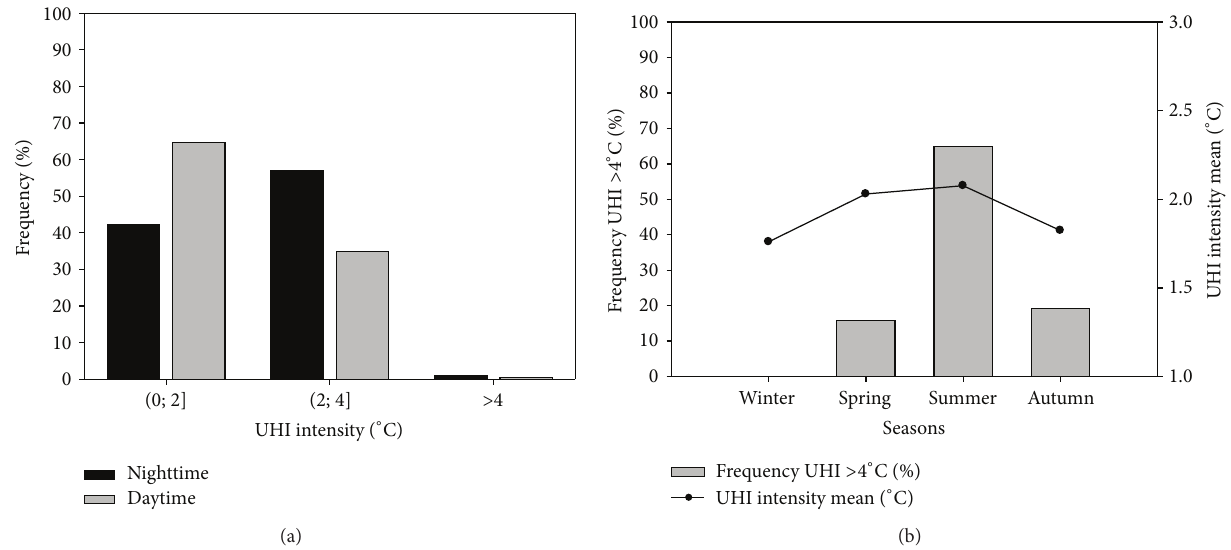
Figure 8: Frequency of the UHII during night- and daytime periods (a) and seasons (b). Winter: DJF; Spring: MAM; Summer: JJA; Autumn